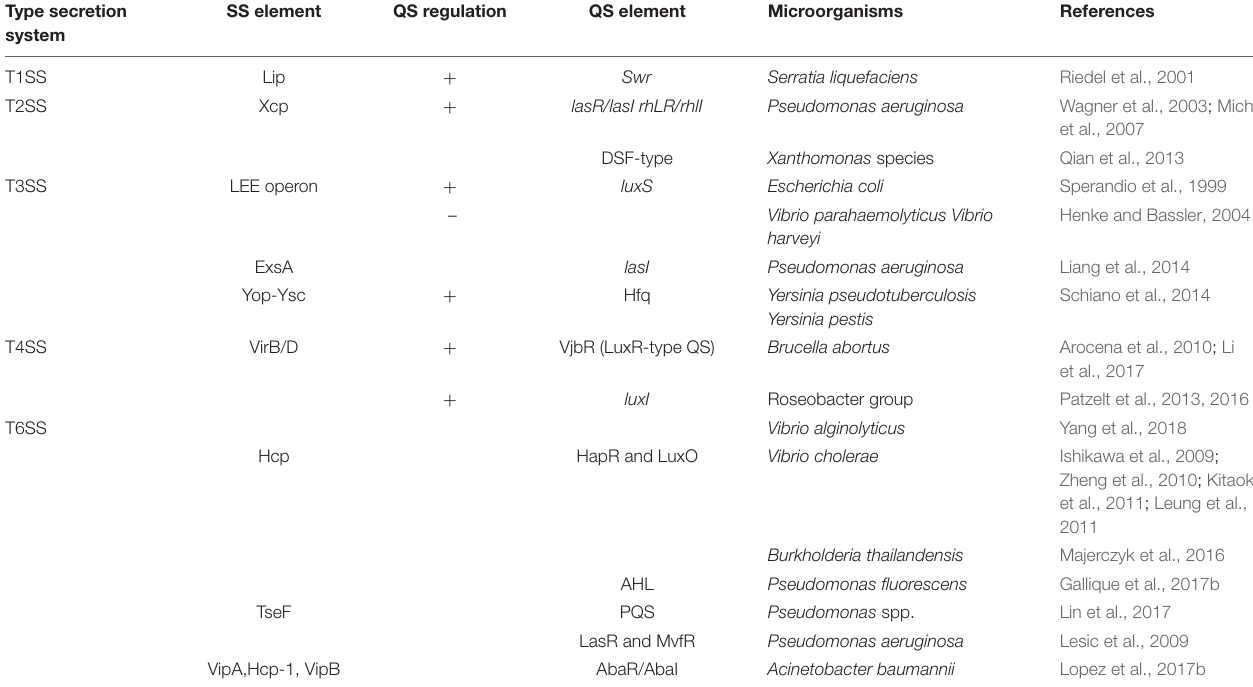
TABLE 1 | Pathogens and QS elements related to secretion